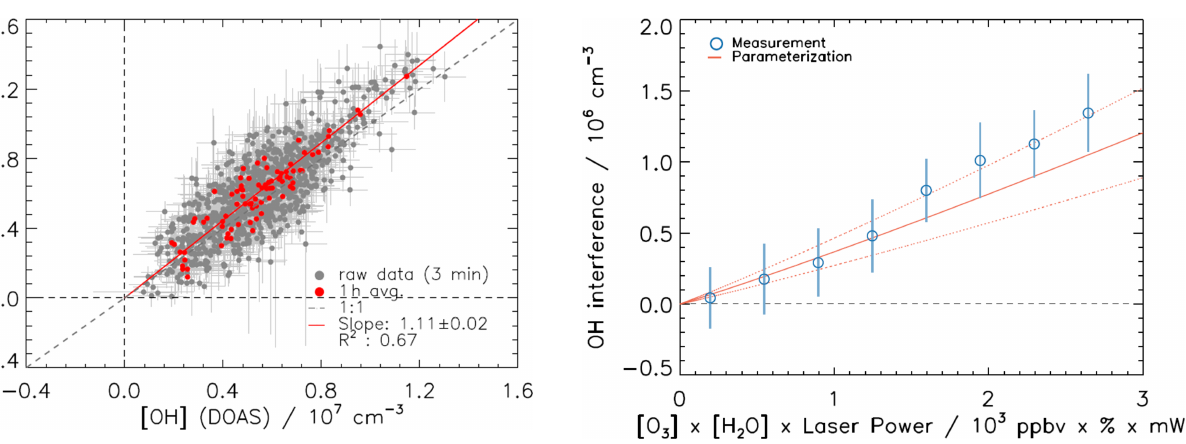
Figure 12. Correlation plot between OH concentrations measured by the FZJ-LIF-CMR and the DOAS instruments during the sum- mer period of the JULIAC campaign except for the heat wave pe- riod between 22 and 26 August. The 1436 data points are averaged over 3min and 1h. The red line is a linear fit of the 3min data set weighted with the statistical errors of both instruments and forced to the origin. Vertical bars denote the 1 σ precision of the measured data points.